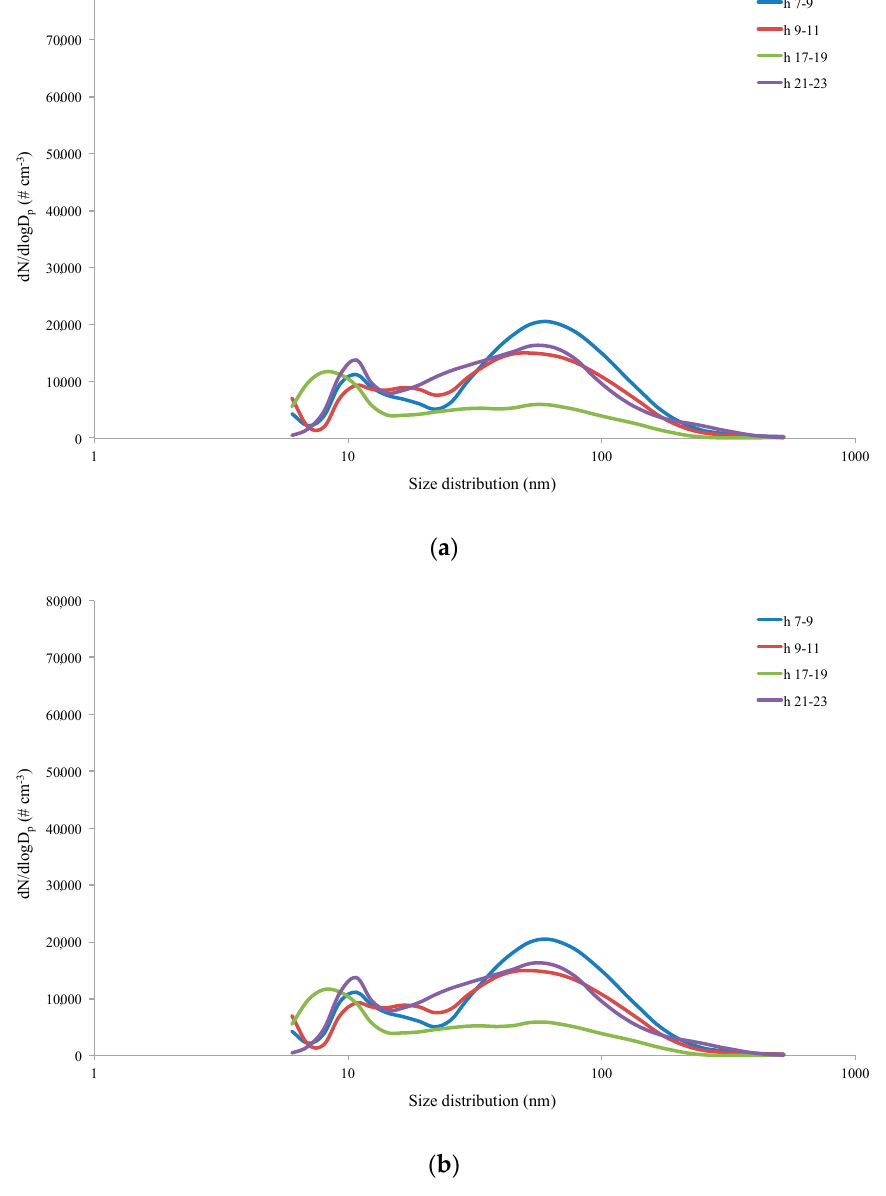
Figure 5. Typical daily size distribution in downtown Rome on weekdays ( a ) and weekends ( b ).